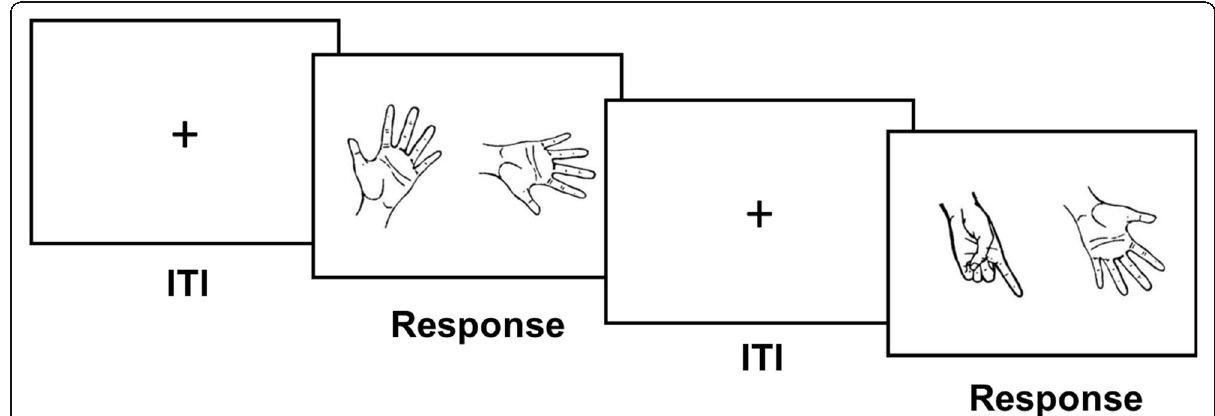
Fig. 3 The flow of two trials. The intertrial interval (ITI) is 1000 ms. During the response, the task of the participant is to decide whether the two hand stimuli are the same hand or different